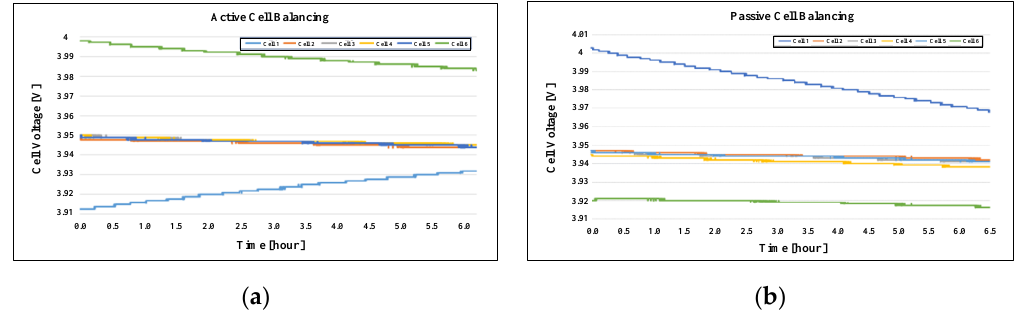
Figure 8. Experimental cell-balancing circuit prototype: ( a ) the ACB circuit; ( b ) the PCB circuit.